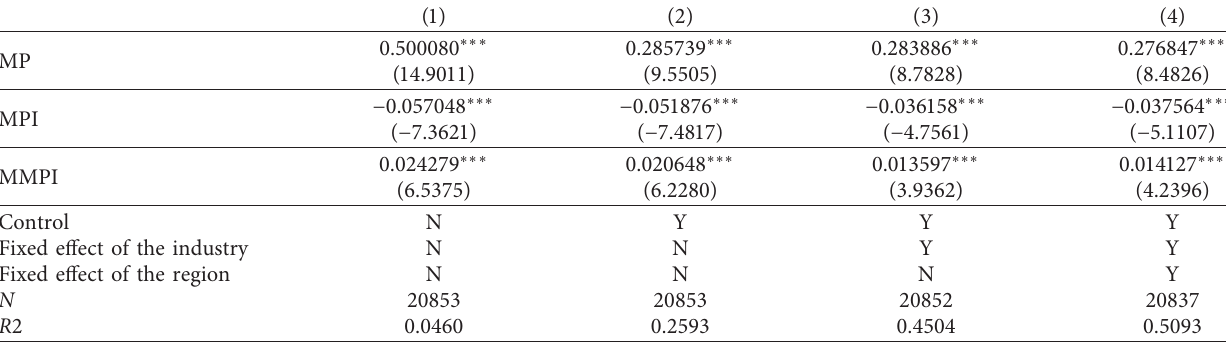
Table 3: Regression results of the baseline